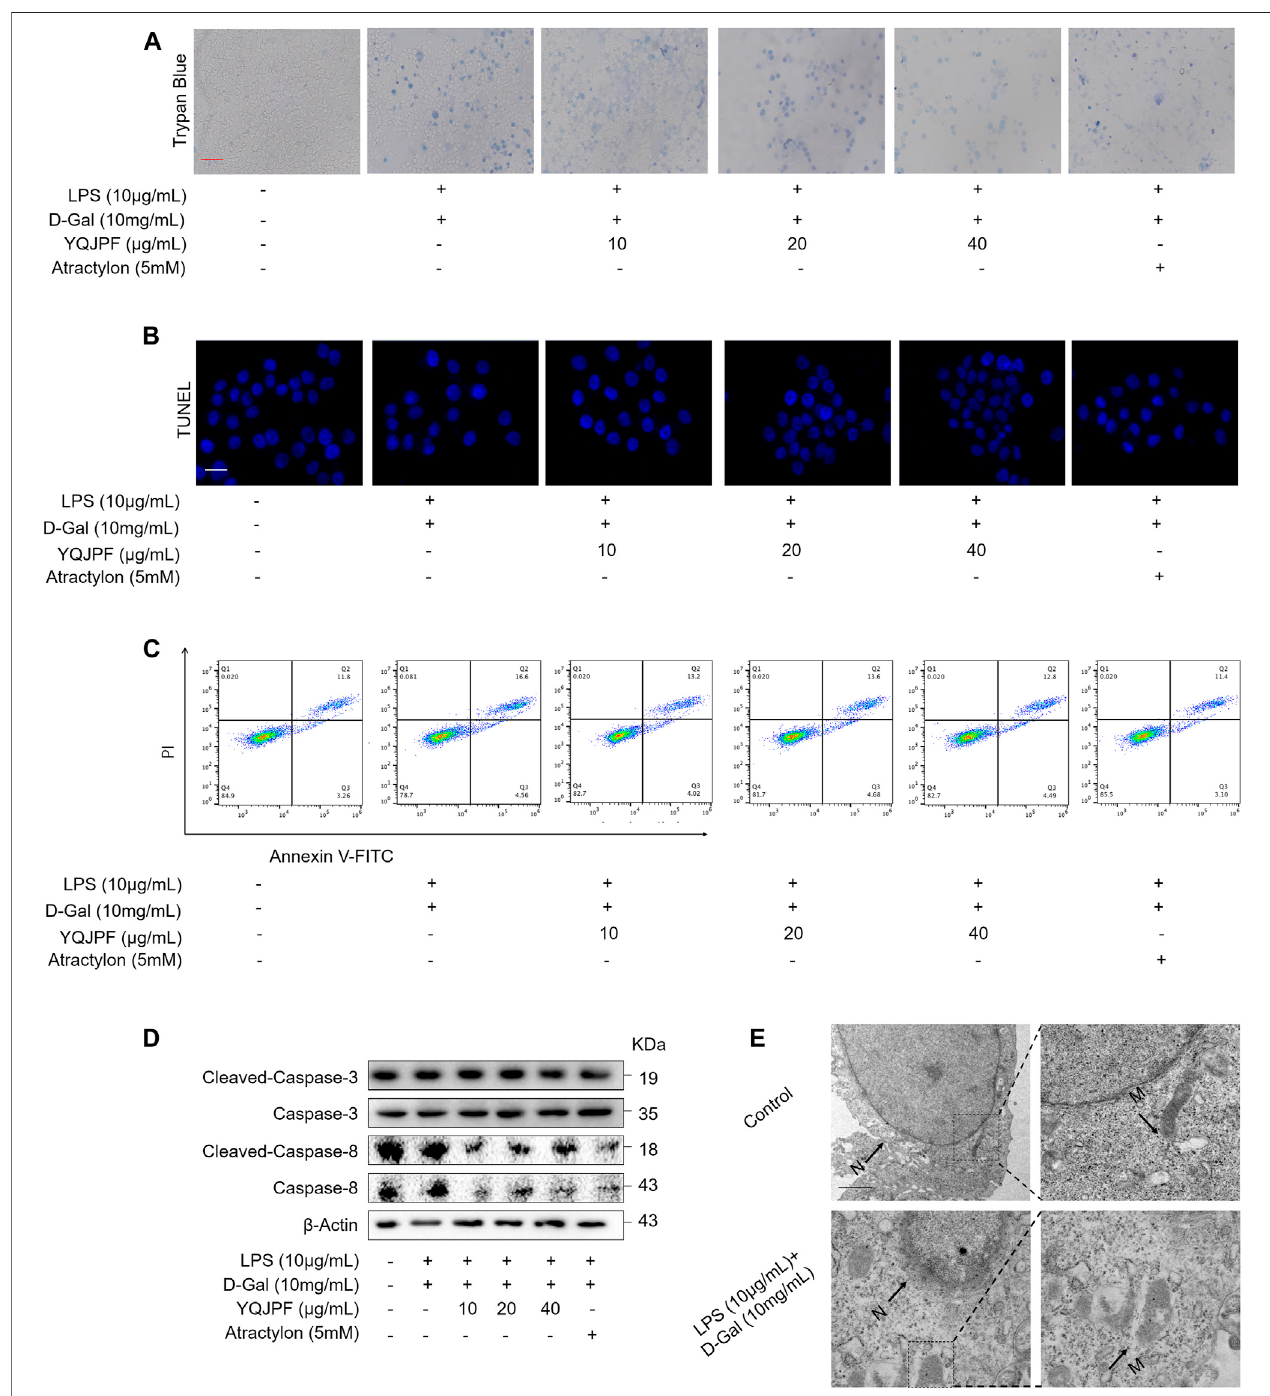
FIGURE 5 | YQJPF inhibited hepatocytic cell death, which was not by apoptosis, in LPS- and D-Gal-treated LO2 cells in vitro . Human LO2 cells were treated with LPS + D-Gal for 4 h and further with YQJPF and atractylone. (A) Trypan blue staining to detect cell death. Scale bar, 100 μ m. (B) TUUNEL staining to detect cell apoptosis. (C) Western blotanalysisofthe protein expression ofcaspases three and eight and cleaved caspases three and eight inthetreatedhuman LO2cells. (D) cell apoptosis assay by fl ow cytometer in the treated human LO2 cells. (E) Transmission electron microscopy (TEM) of cells. Black arrows represent swollen mitochondria(M),whereaswhitearrowsrepresentcondensedandmarginatedchromatinsinnuclei(N).Dataareexpressedasmean ± SD( n (cid:2) 3).*vs.controlgroup, # vs. LPS + D-Gal group; * p < 0.05, ** p < 0.01; # p < 0.05, ## p < 0.01.